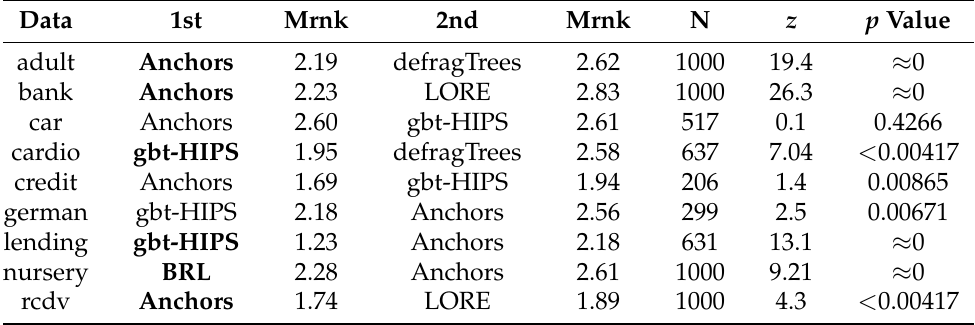
Table 6. Reliability significance tests: top two methods by mean rank (mrnk) for the stochastic GBT